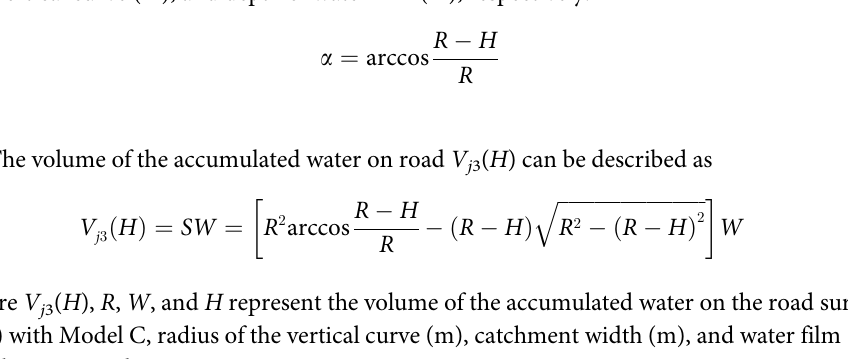
ffiffiffiffiffiffiffiffiffiffiffiffiffiffiffiffiffiffiffiffiffiffiffiffiffiffiffiffiffi